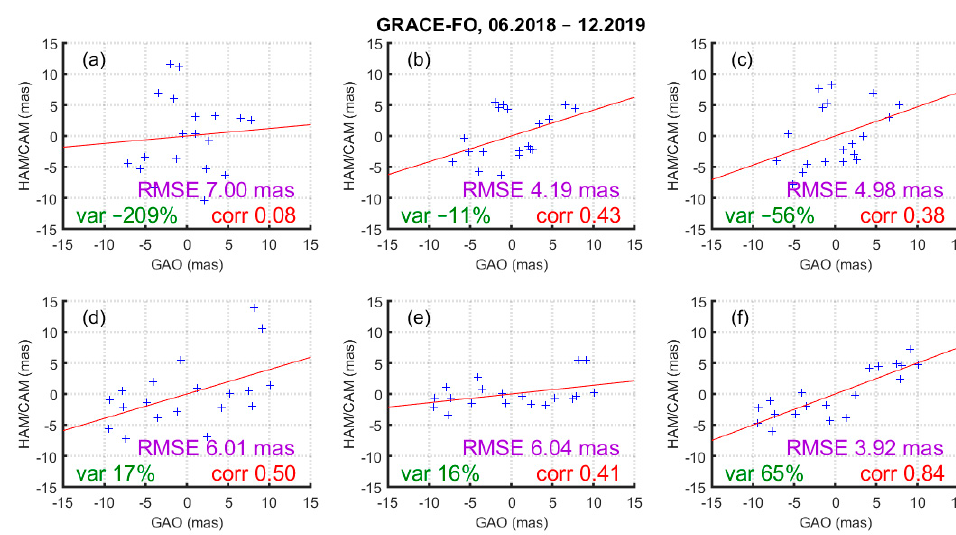
Figure 15. Scatter plots showing the relationship between χ 1 component of GAO and HAM/CAM from ( a ) JPL GSM, ( b ) JPL TWS, and ( c ) JPL MAS, and scatter plots showing the relationship between χ 2 component of GAO and HAM/CAM from ( d ) JPL GSM, ( e ) JPL TWS, and ( f ) JPL MAS. The red line was fitted to the data points using the least squares method. The values in purple indicate the RMSE, the values in red (corr) indicate the correlation coefficients between series, and the values in green (var) indicate the relative explained variances. The considered time period is April 2002 to June 2017. Note that the critical value of correlation coefficient for 63 independent points and a 95% confidence level is 0.21, while the standard error of the difference between two correlation coefficients is 0.18. All the parameters were computed after removal of trends.